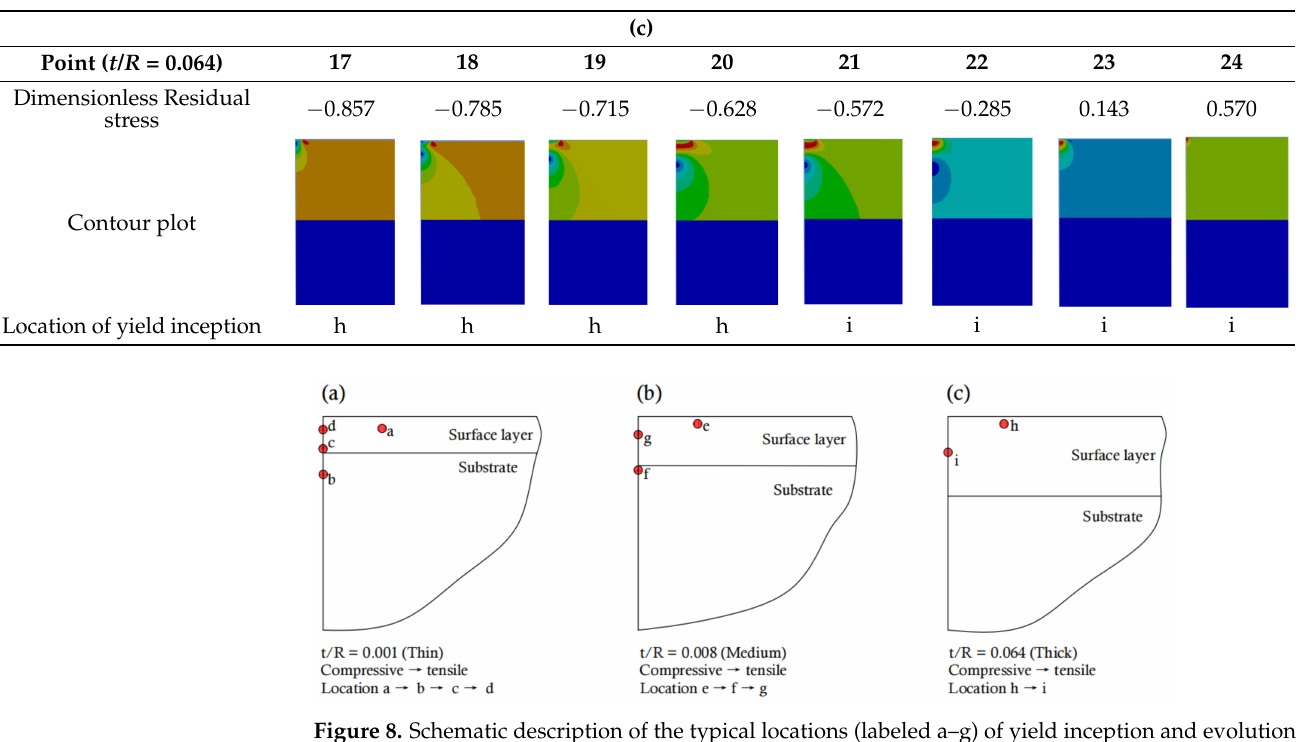
Figure 8. Schematic description of the typical locations (labeled a–g) of yield inception and evolution rule as the residual stress varied from compressive to tensile for different surface layer thicknesses. ( a ) t / R = 0.001. ( b ) t / R = 0.008. ( c ) t / R =